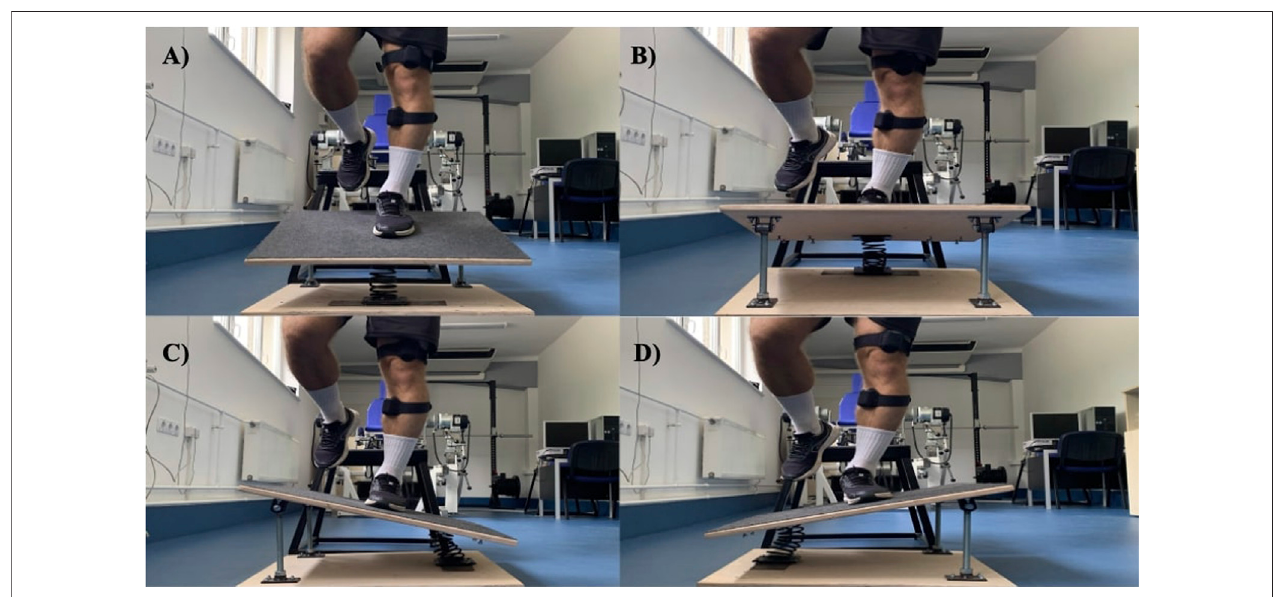
FIGURE 3 | Landings on the custom-built balance board with four different tilt options: (A) ankle plantar fl exion, (B) ankle dorsi fl exion, (C) ankle inversion, (D) ankle eversion.